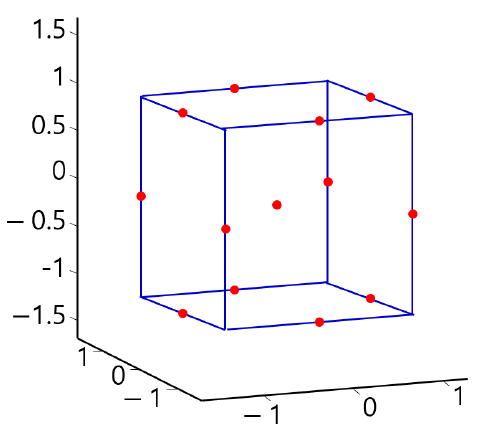
Figure 6. Box–Behnken design.